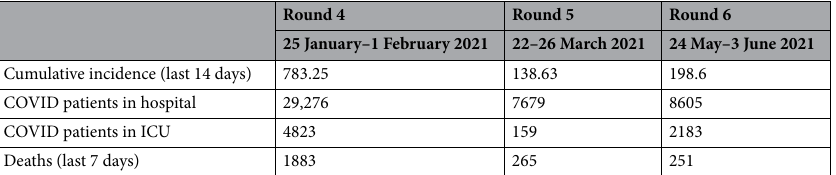
Table 1. Epidemiological situation in the different rounds. Source: Spanish Health Alert and Emergency Coordination Centre (CCAES). https:// www. mscbs. gob. es/ profe siona les/ salud Publi ca/ ccayes/ alert asAct ual/